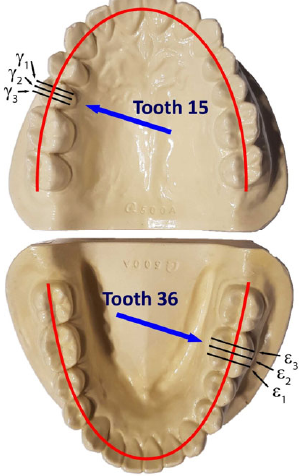
Figure 6. The location of the teeth in the view of the maxillary and mandibular arches with the